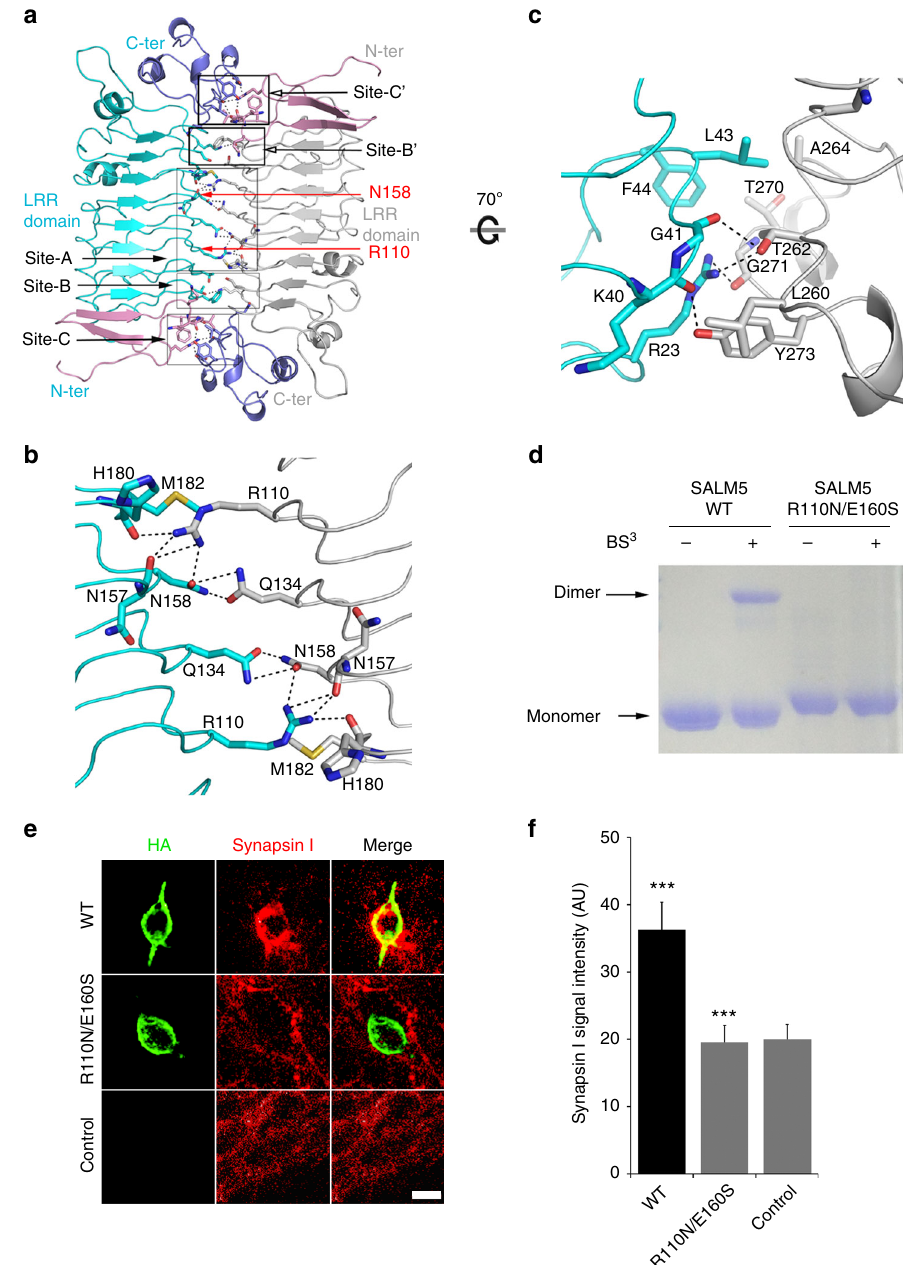
Fig. 2 Structural, biochemical, and functional characterizations of SALM5 dimerization. a Top view of the dimeric SALM5 LRR domains (from the 2.8 Å free SALM5 structure) represented in ribbons with residues on the dimer interface displayed as sticks. The LRR domains of two protomers are colored in cyan and gray, respectively. For clarity, R110 and N158 from one protomer are labeled. The N and C terminus of each molecule are, respectively, labeled as “ N- ter ” and “ C-ter ” . LRRNT: pink; LRRCT: slate; oxygen atoms: red; nitrogen atoms: blue; hydrogen bonds and salt bridges: black dashed lines. b Close-up view of the site A in a . c Close-up view of the site C in a , with a 70° rotation along the horizontal line. d SDS-PAGE analysis of the wild-type SALM5 LRR-Ig and its R110N/E160S mutant in the presence or absence of BS 3 . e Representative images of the heterologous synapse formation activities of the wild-type full- length SALM5 ectodomain and its mutant R110N/E160S. Scale bar, 20 μ m. The neurons were co-cultured with HEK293T cells transfected with plasmids for the HA-tagged wild-type SALM5 (WT) and its mutant (R110N/E160S) or empty vector (control), and stained with antibodies against HA-tag (green) and synapsin-I (red). The synapse-forming activity was quanti fi ed by measuring the intensity of immunostained synapsin-I around HEK293T cells. f Quanti fi cation of the result in e . n = 21 fi elds of view, *** p < 0.005 for WT vs control or mutant vs WT, Student ’ s t test. Error bars present standard error of the mean